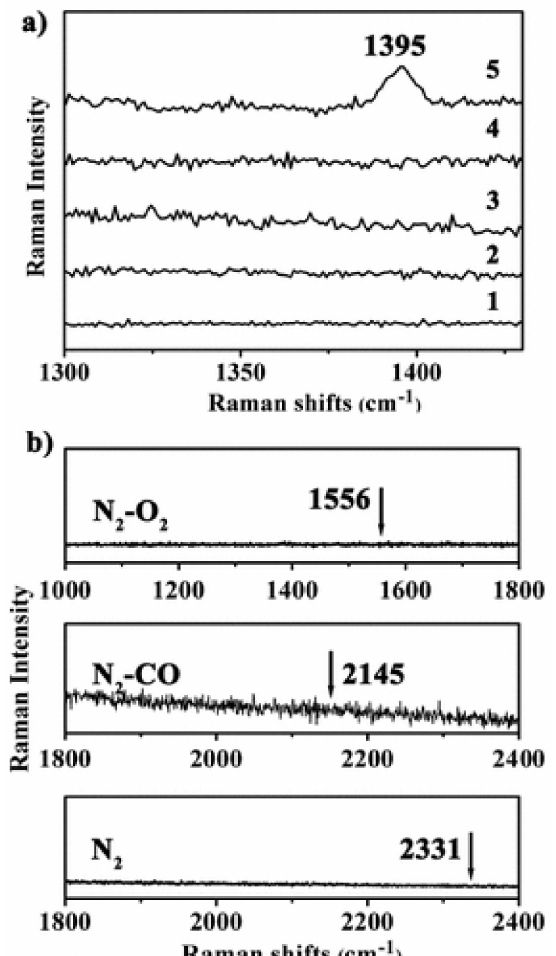
Figure11. ( a )SERSofsingleAuNPs(trace1), ofsingleMOF-5(trace2), andsinglecore–shellAu@MOF-5 NPs presenting shell thickness of 69.0 ± 12.4 nm (trace 3), 25.1 ± 4.1 nm (trace 4), and 3.2 ± 0.5 nm (trace 5) towards CO 2 in the CO 2 / N 2 mixture, and ( b ) SERS spectra of Au@MOF-5 NP with a shell thickness of 3.2 ± 0.5 nm towards N 2 , CO, and O 2 . The characteristic SERS peaks of N 2 , CO, and O 2 are shown by arrows. Reprinted with permission from [77]. Copyright John Wiley and Sons,